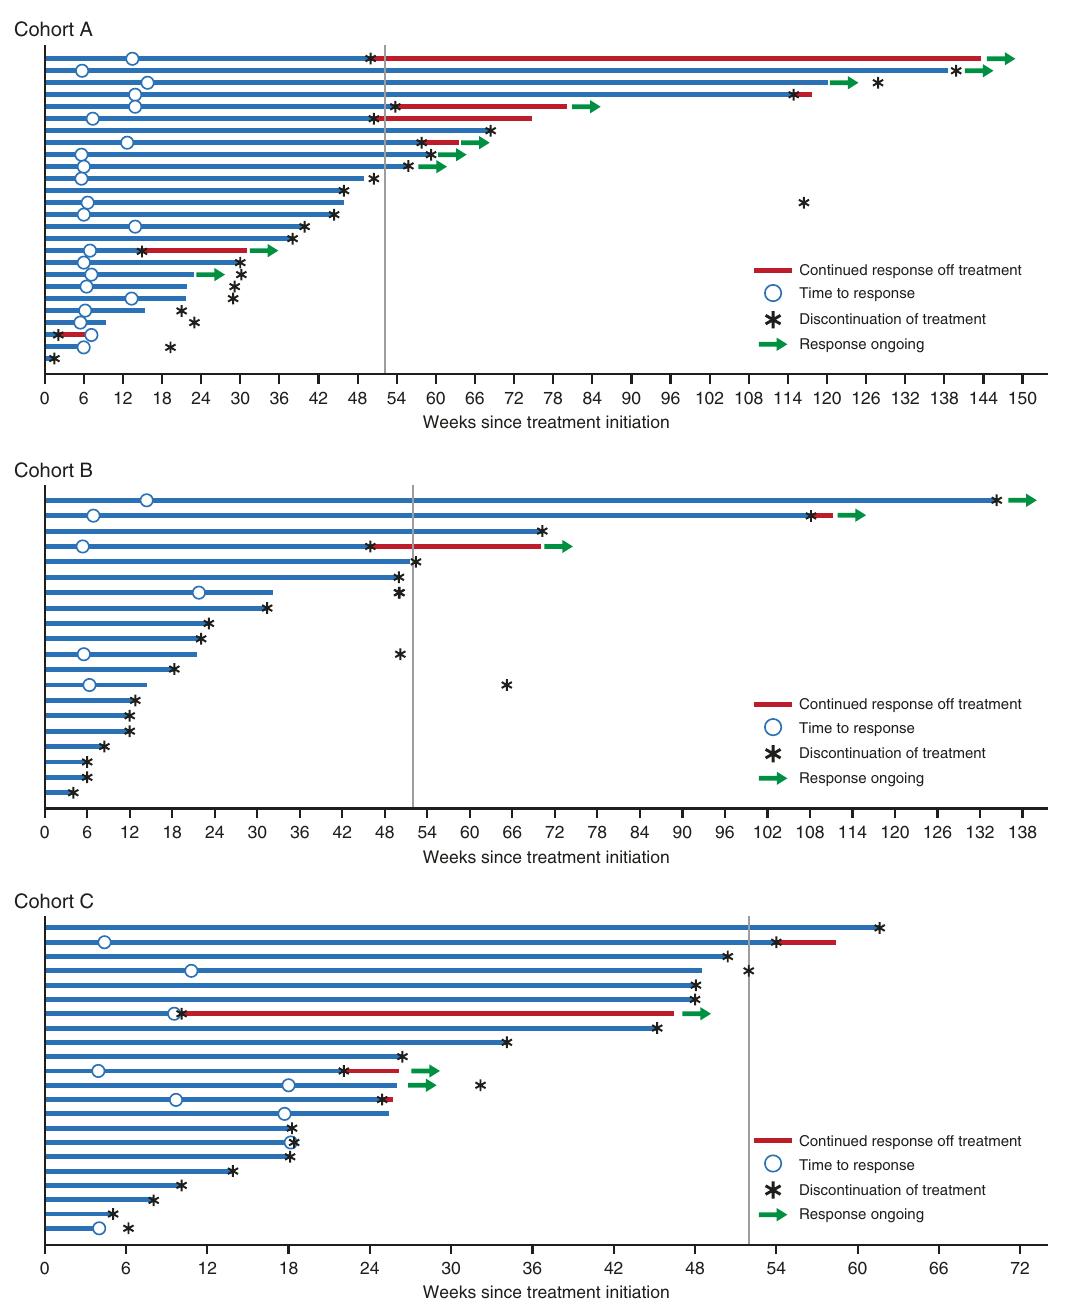
Fig. 2 Duration of response (as-treated population). Vertical lines indicate planned 12 months of treatment with durvalumab. Cohort A, n = 26; Cohort B, n = 20; Cohort C, n =